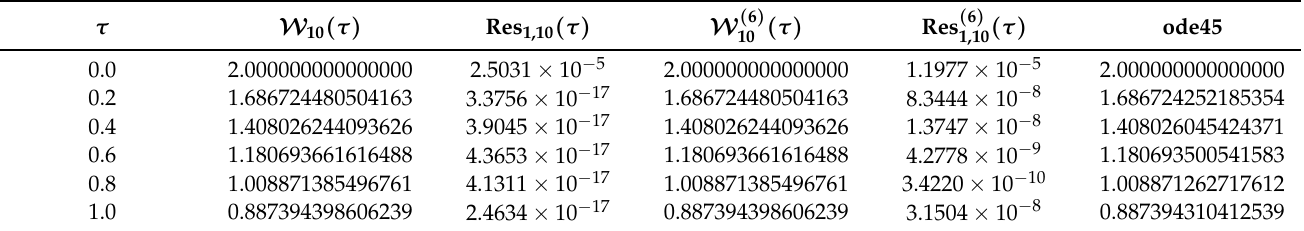
Table 4. The comparison of numerical results for in Test Case 2.